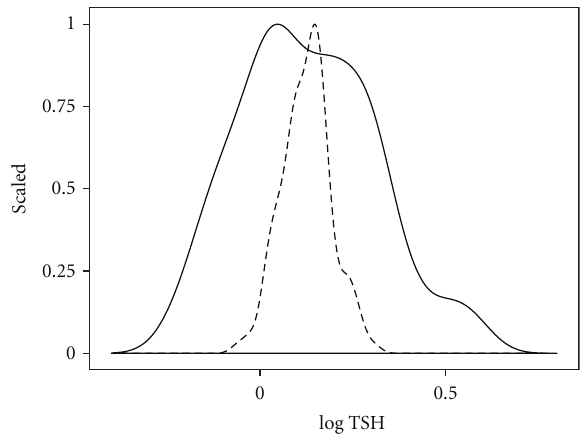
Figure 2: Distribution of log TSH in a group versus an individual. The TSH distribution in the group (solid line) was derived from 150 euthyroid subjects, with the individual spread (broken line) assumed to comprise 50% of the group variation (according to Andersen et al.